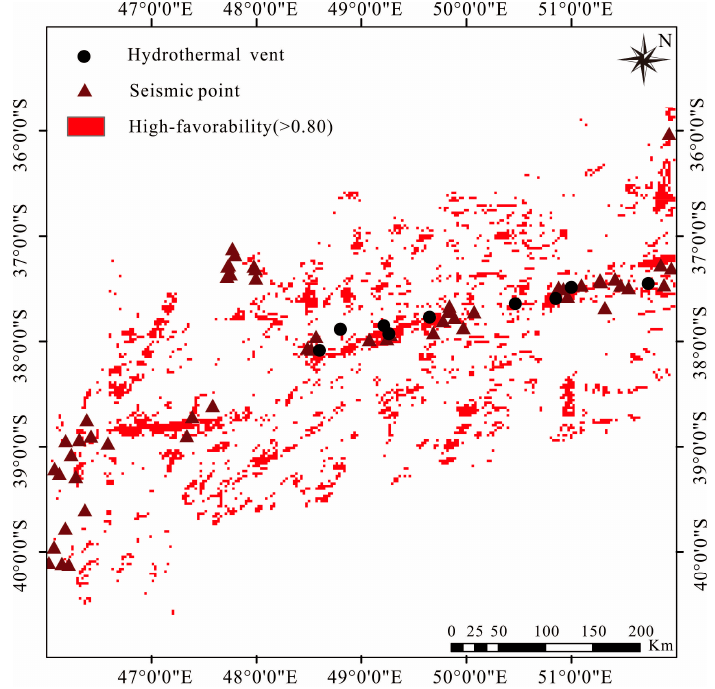
Figure 9. Mineral prospective map based on fuzzy logic.